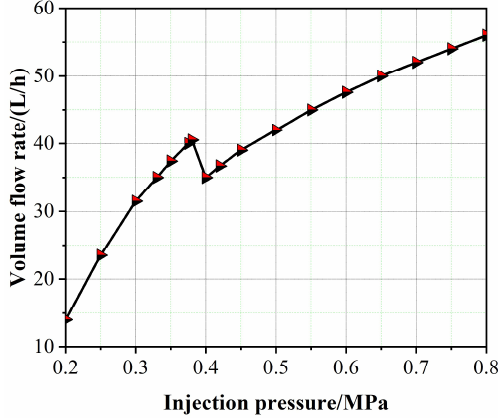
Figure 12. Relationship between volume flow rate and injection pressure of single cylindrical noz-